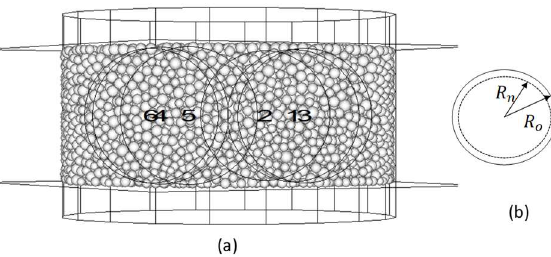
Fig. 5 . (a) Diagram showing balls stacked within the boundaries. The measurement spheres have been demarcated as circles (b) descriptive diagram of radius reduction in each